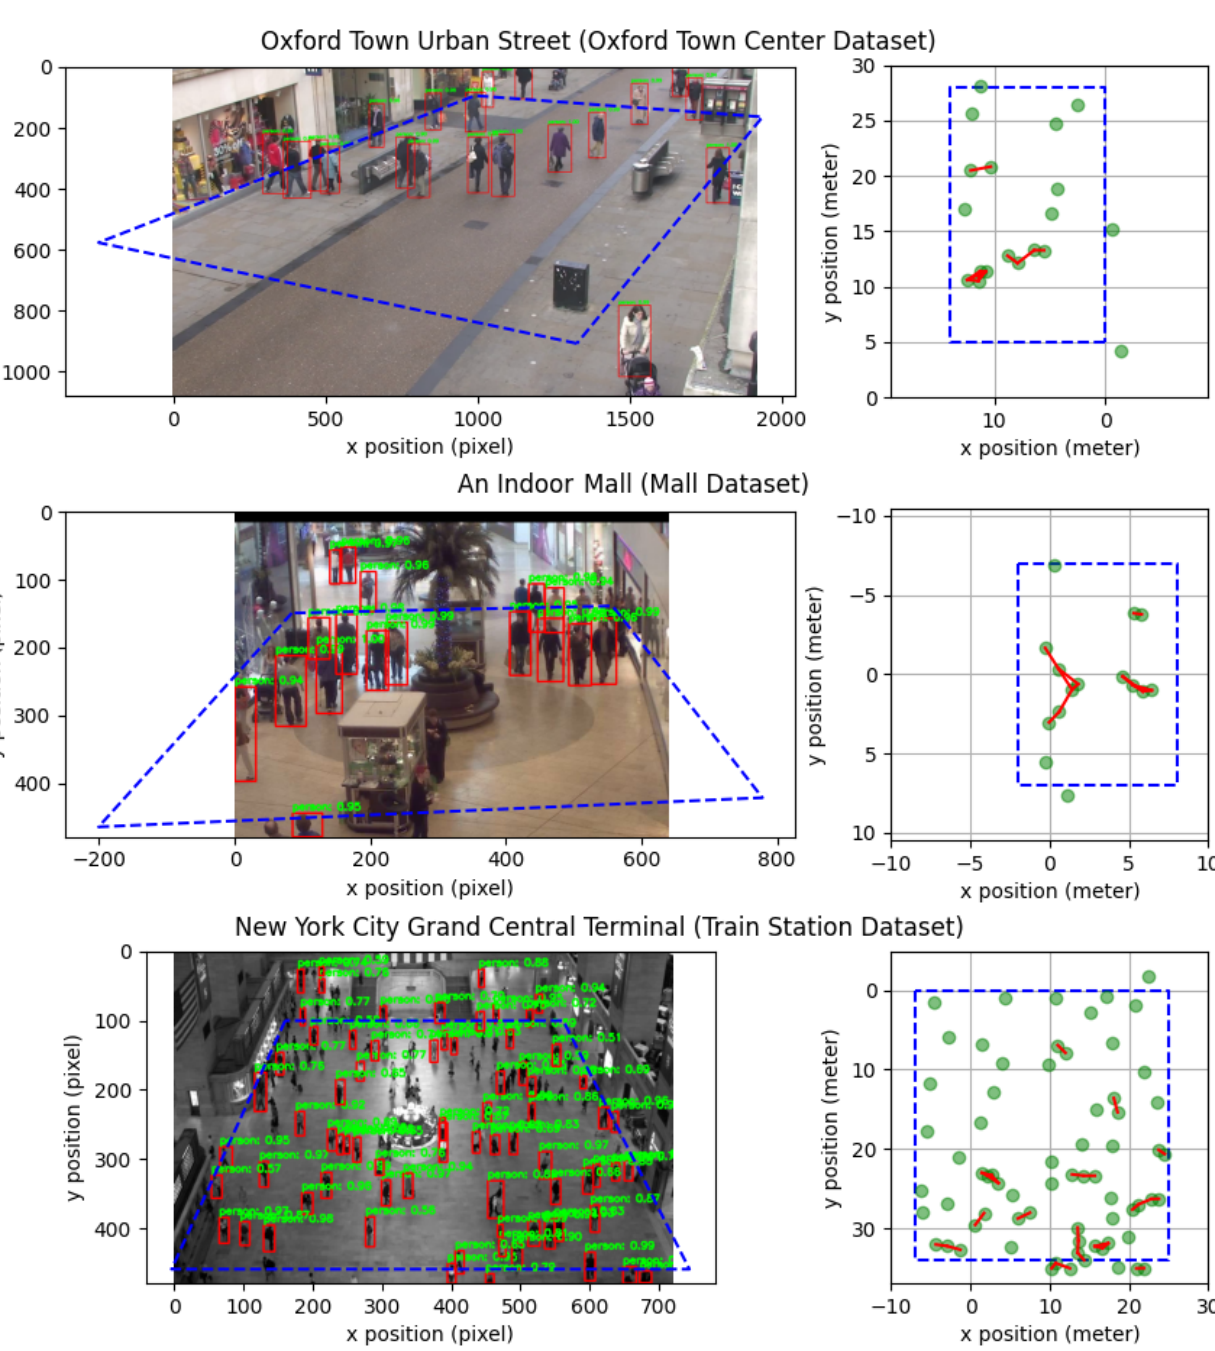
Figure 3. Illustration of pedestrian detection using Faster R-CNN [13] and the corresponding social